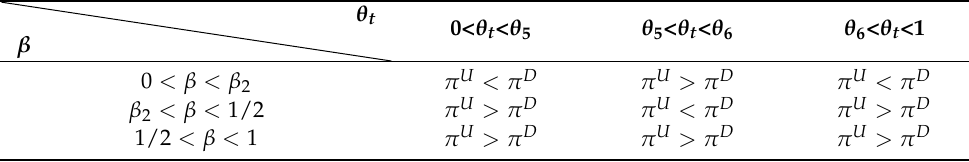
θ t 0< θ t < θ 5 θ 5 < θ t < θ